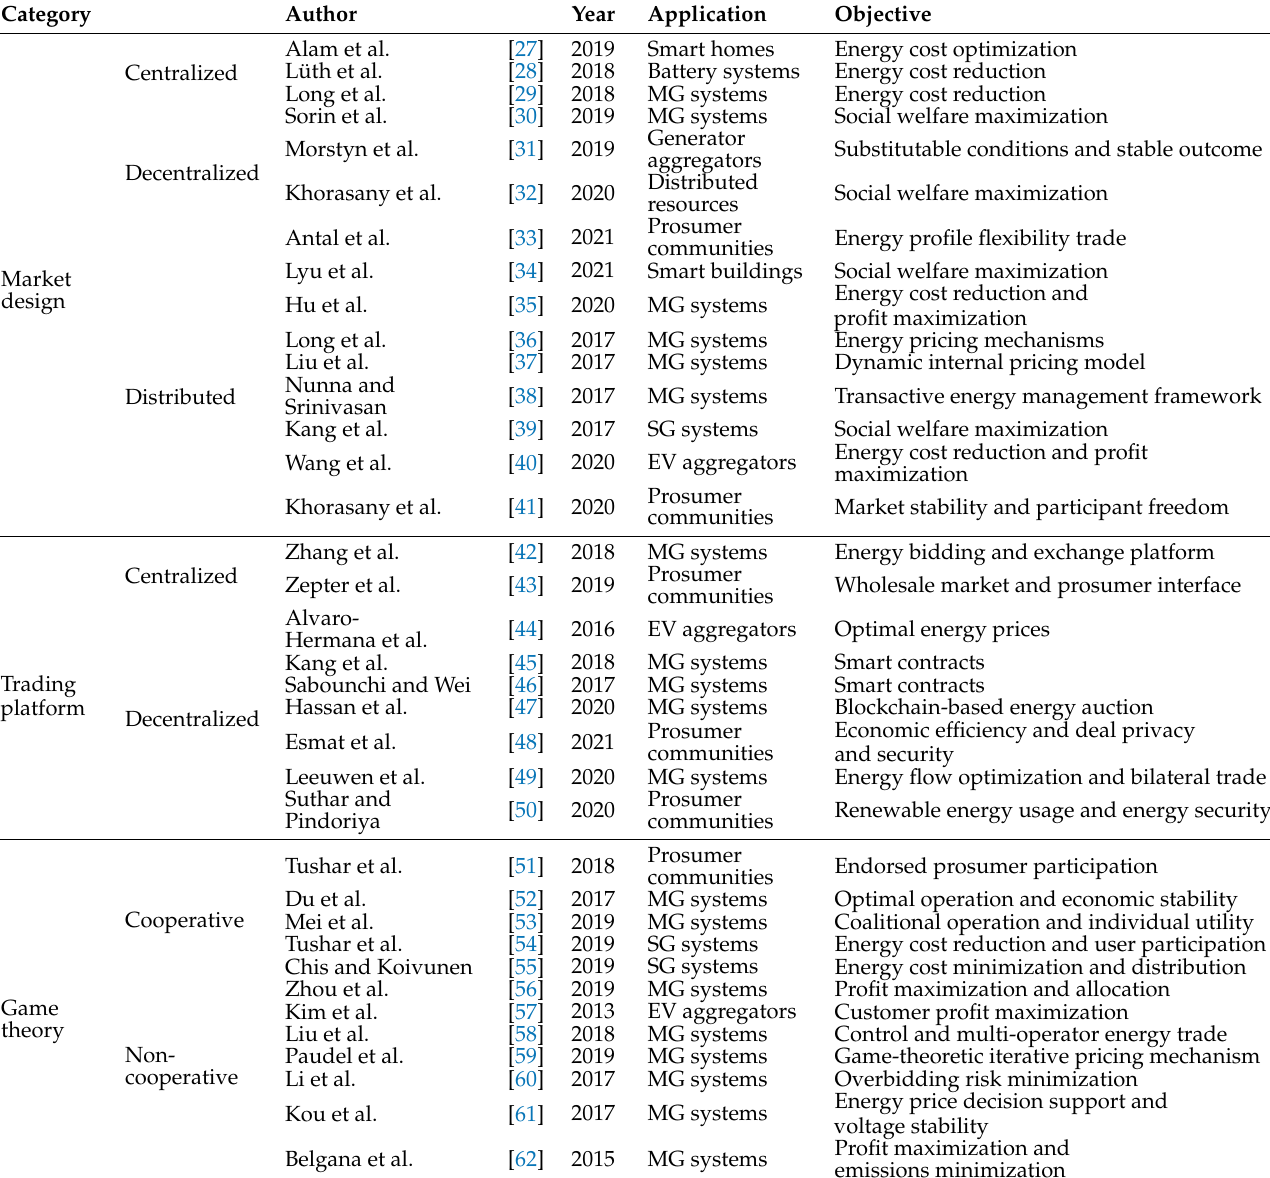
Table 1. Selection of literature works proposing market design models, trading platforms, and game-theoretic approaches for P2P energy trading in